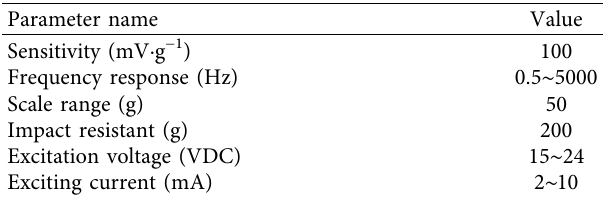
Table 6: The relevant parameters of the piezoelectric acceleration